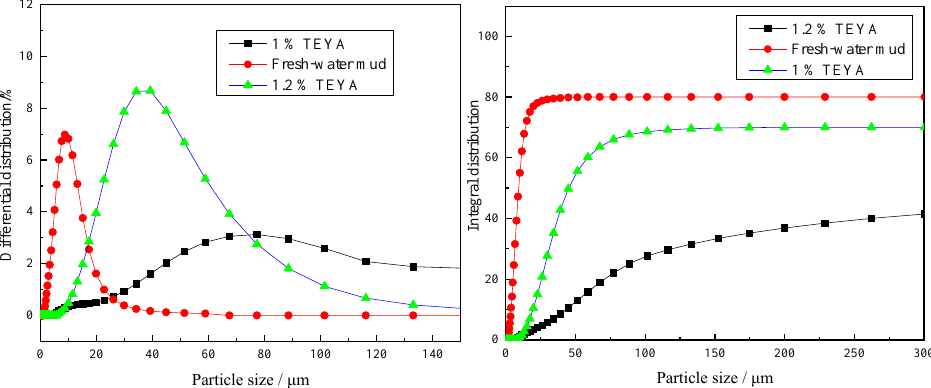
Figure 4. The differential distribution of bentonite treated by several anti-swelling agents: differential distribution/% ( left ); integral distribution ( right ). According to Figure 4, the pitch diameter of water- based slurry was 8.05068 μm and the average diameter was 21.80842 μm. When the inhibitor was added, the median diam- eter was raised to 56.19773 μm and the average diameter was raised to 60.04097 μm. It can be seen that the particle diameter obviously increased, which played a certain role in in- hibiting the hydration and dispersion of shale.